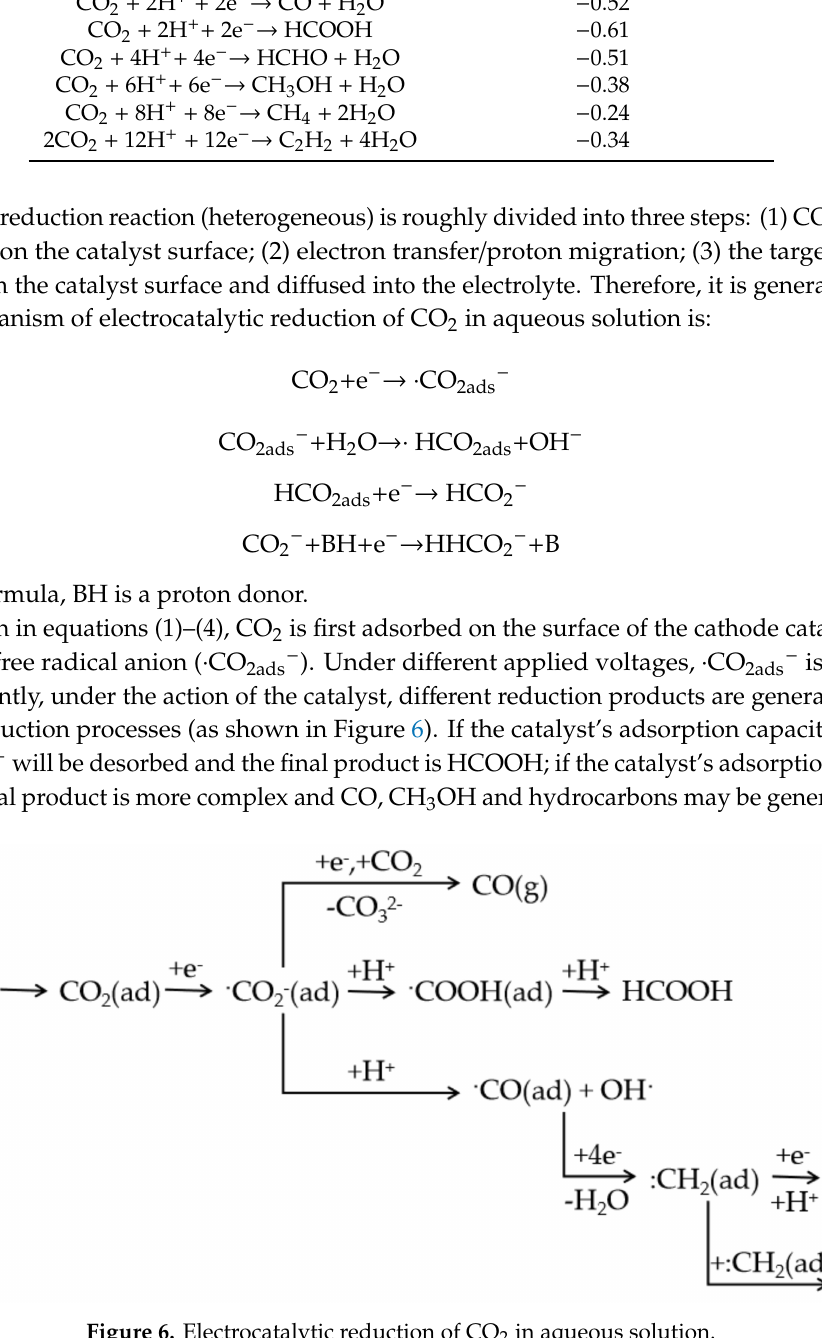
Figure 6. Electrocatalytic reduction of CO 2 in aqueous